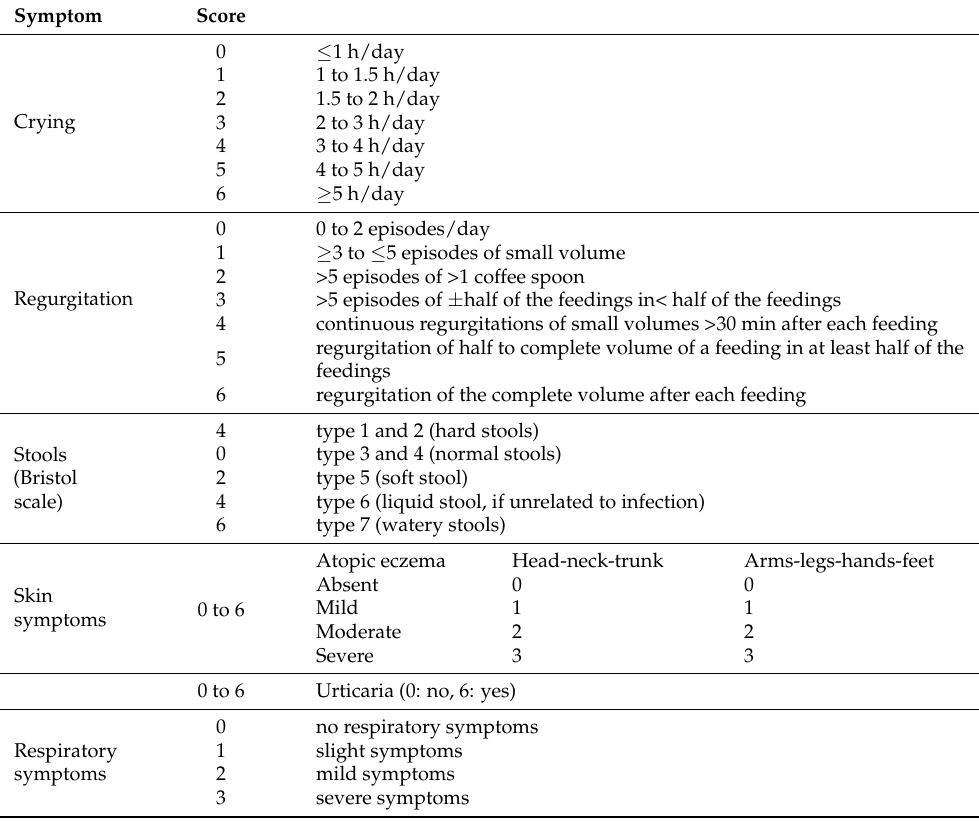
Table 1. The Cow’s Milk-related Symptom Score (CoMiSS ® )